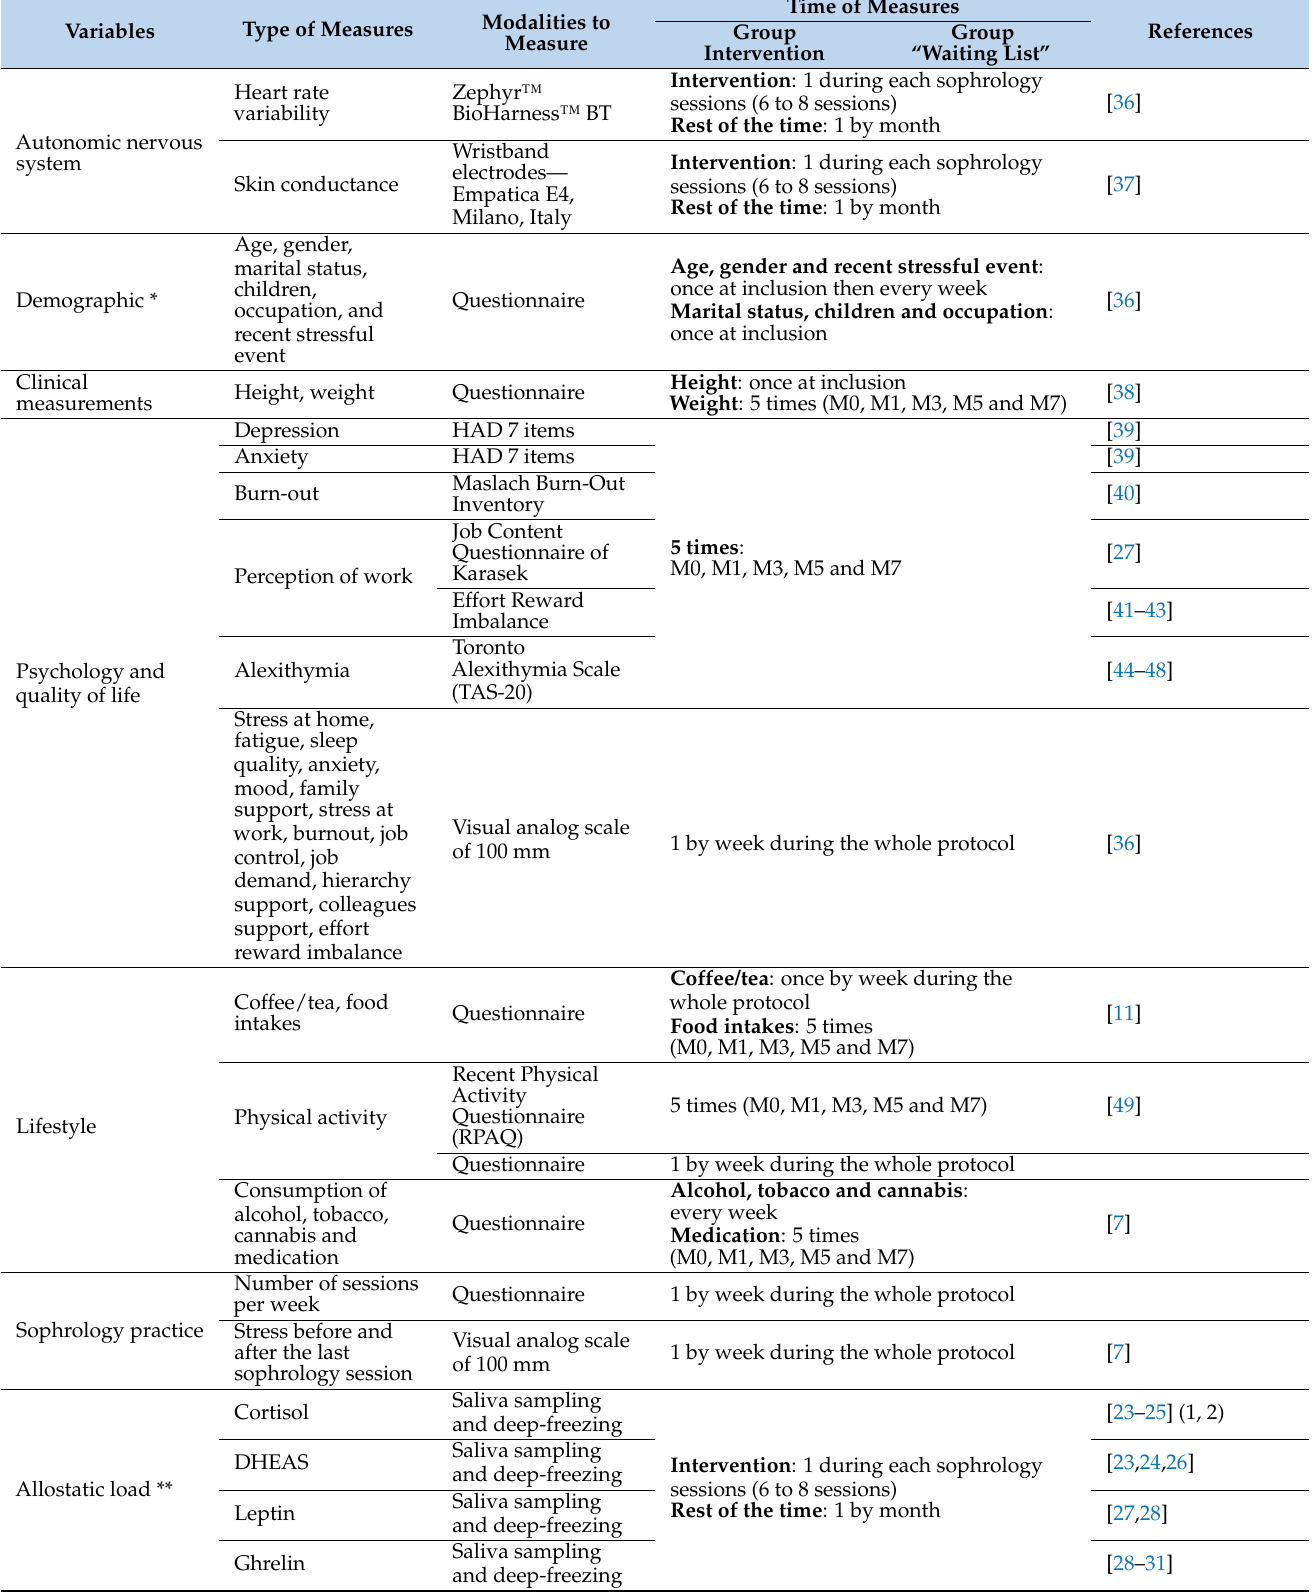
Table 1. Synthesis of primary and secondary